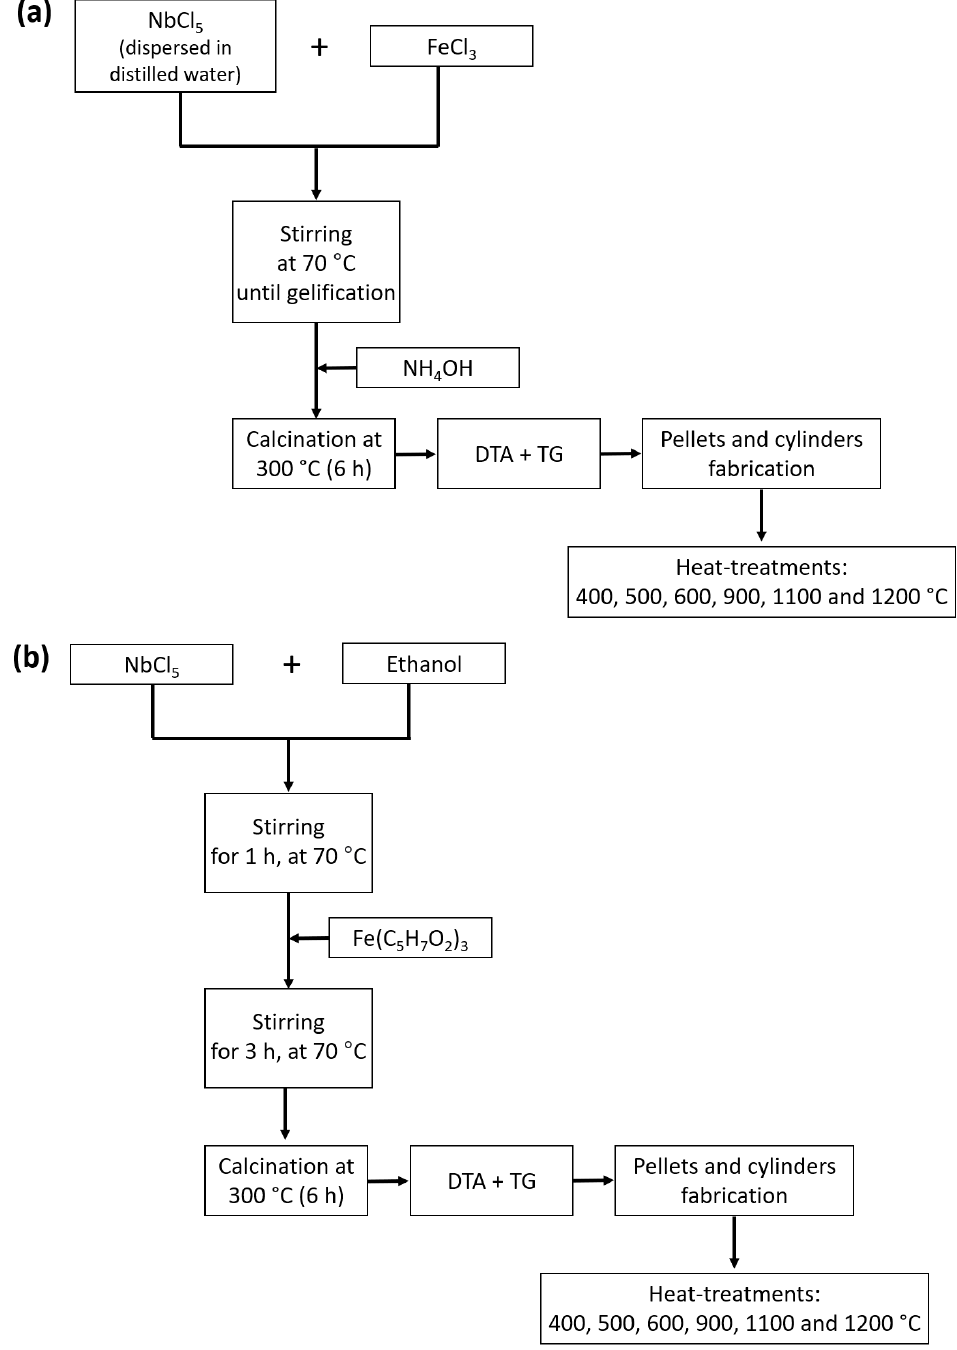
Figure 3. Flow chart for the ( a ) colloidal gel and ( b ) polymeric gel methods.